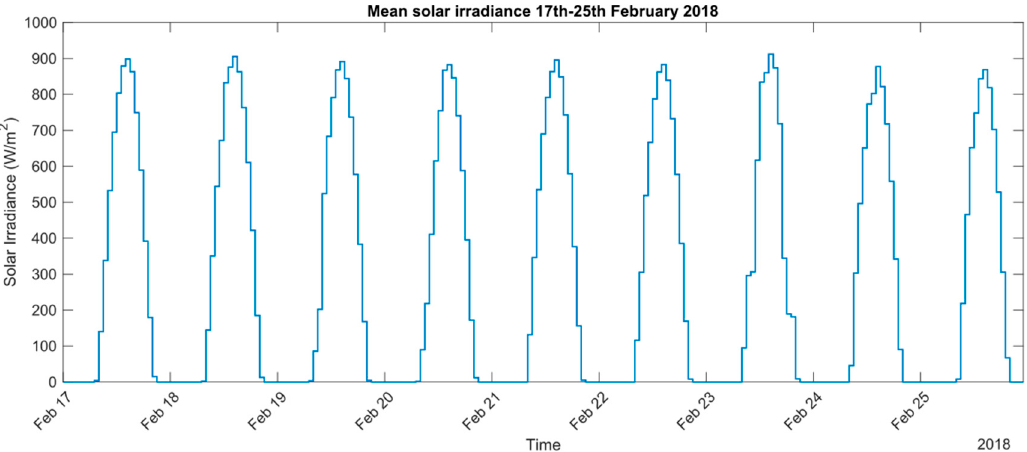
Figure 8. Real mean solar irradiance from February 17th to 25th 2018.